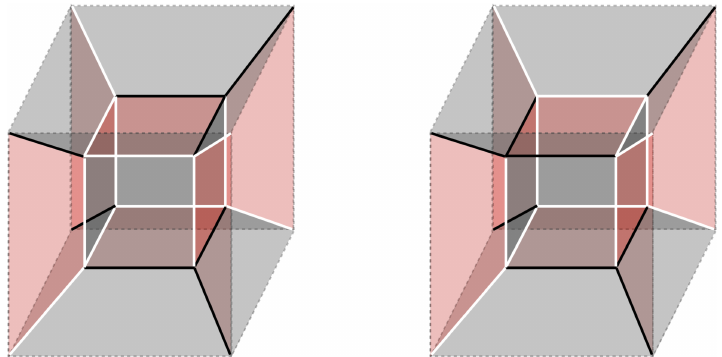
Figure 8 . Two possible edge colorings for the cube model, which are equivalent upon field redefinitions.